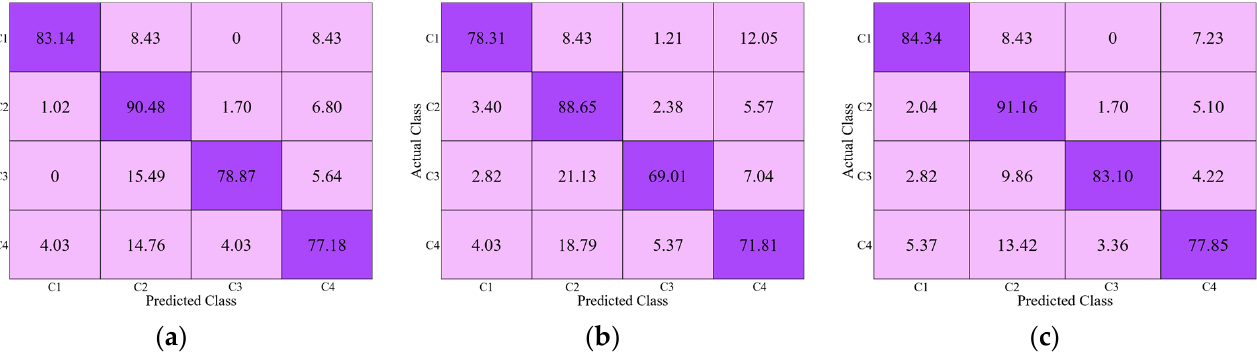
Figure 10. Confusion matrix of ( a ) DenseNet-201 + RIA, ( b ) ResNet-50 + RIA, and ( c ) DRE-Net (sequential training). C1–C4 indicate the classes of four manufacturers of Cofield, Depuy, Tornier, and Zimmer, respectively (unit: %).